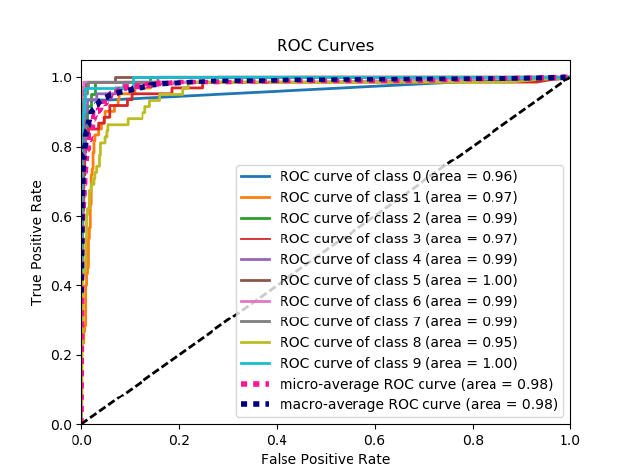
Figure 7. ROC curve example for multi-classes.